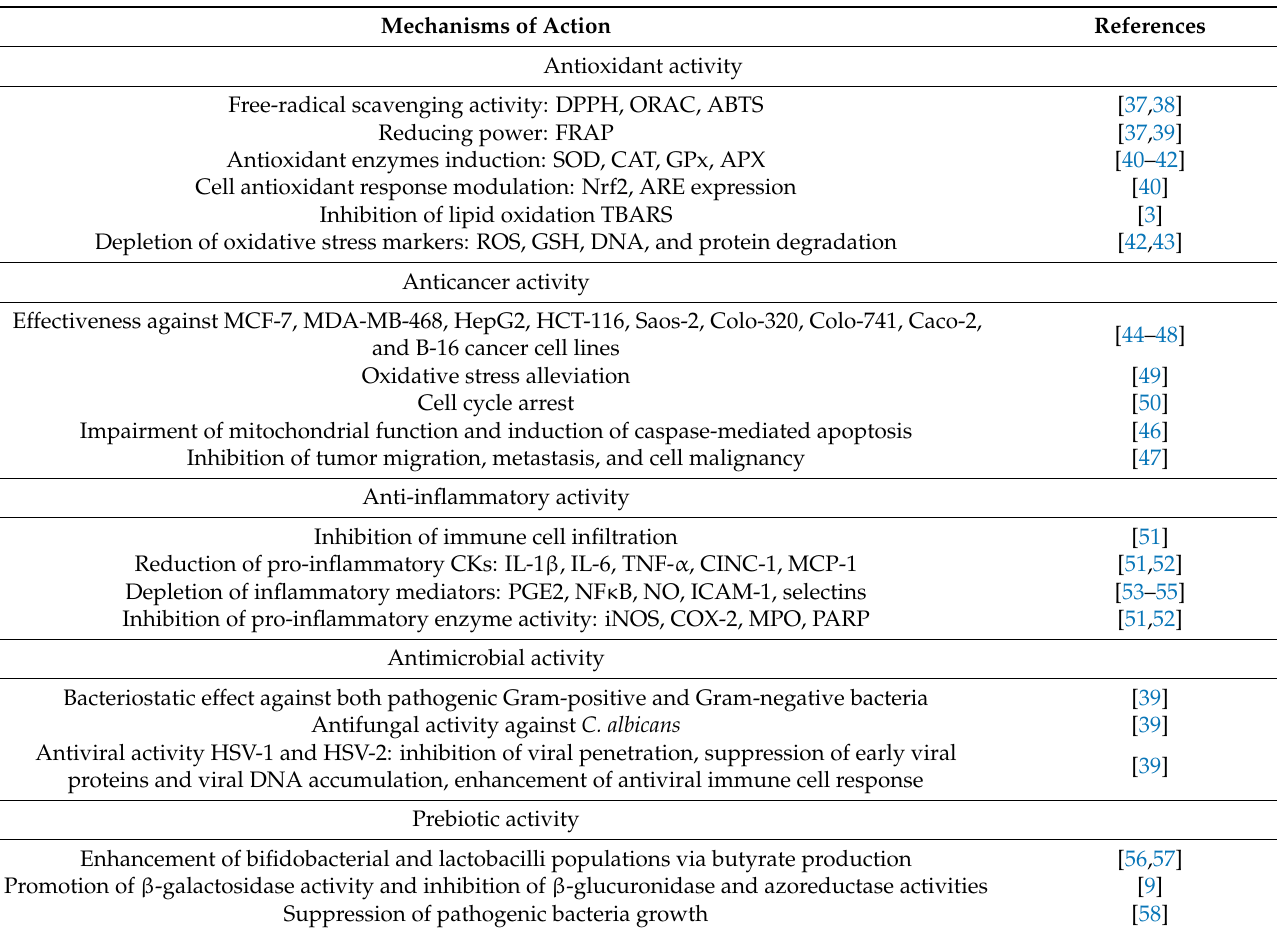
Table 3. Bioactivities of almond and its by-products and their mechanisms of